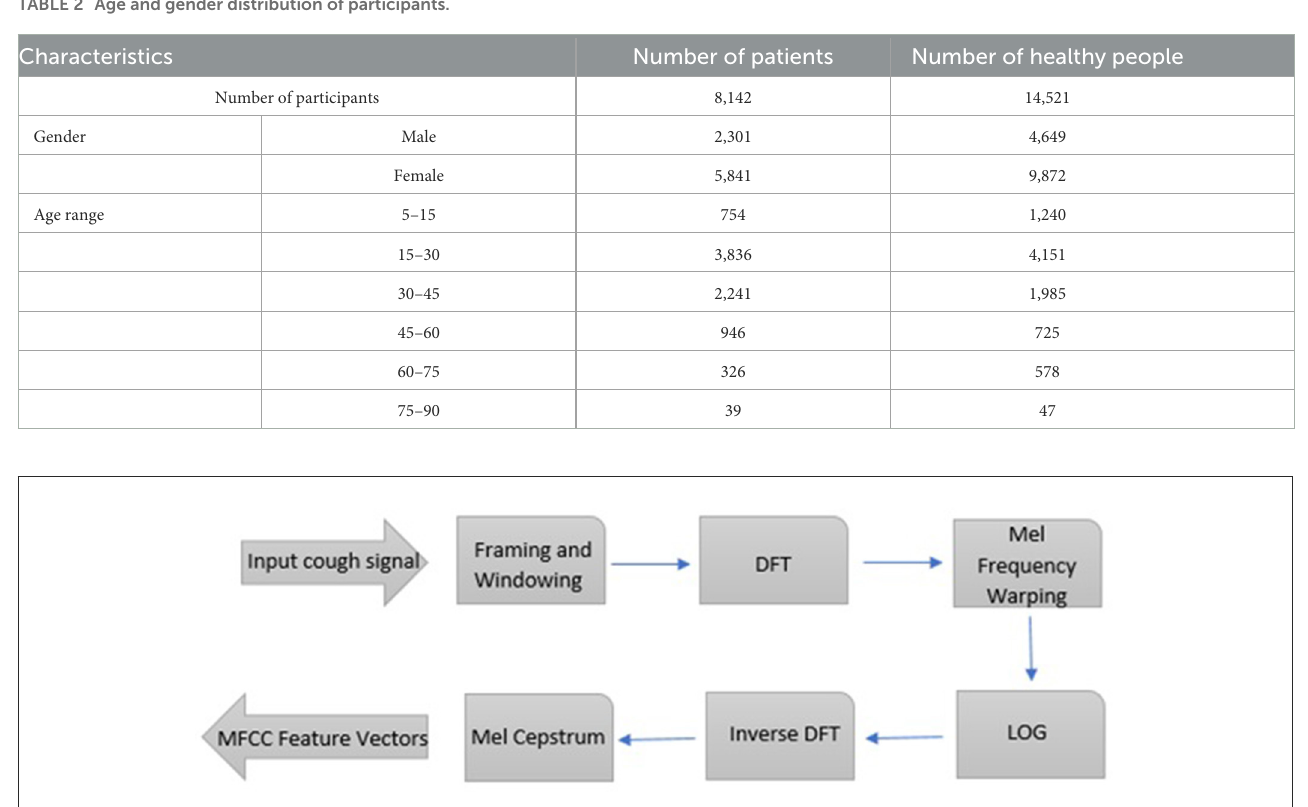
FIGURE2 Steps of capstral conversions of the signal spectrum. Steps to obtain mel-scale capstral coefficients from an audio